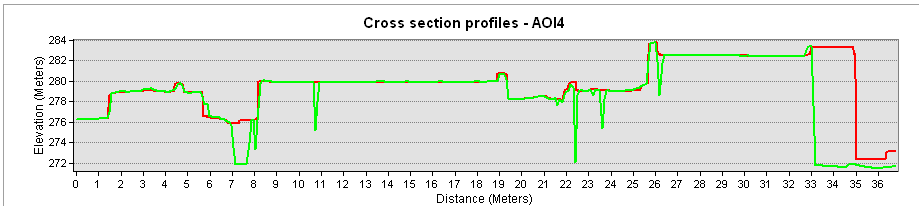
Figure 13. Vertical cross section of DSM obtained from photogrammetric software shown in Red and from Enhanced DSM obtained from research methodology shown in Green for the AOI4